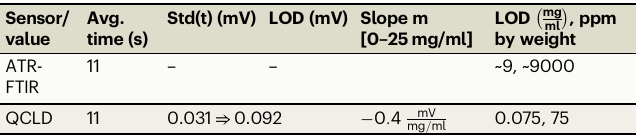
Table 3 | LOD of the ATR-FTIR reference setup & monolithic QCLD-sensor Sensor/